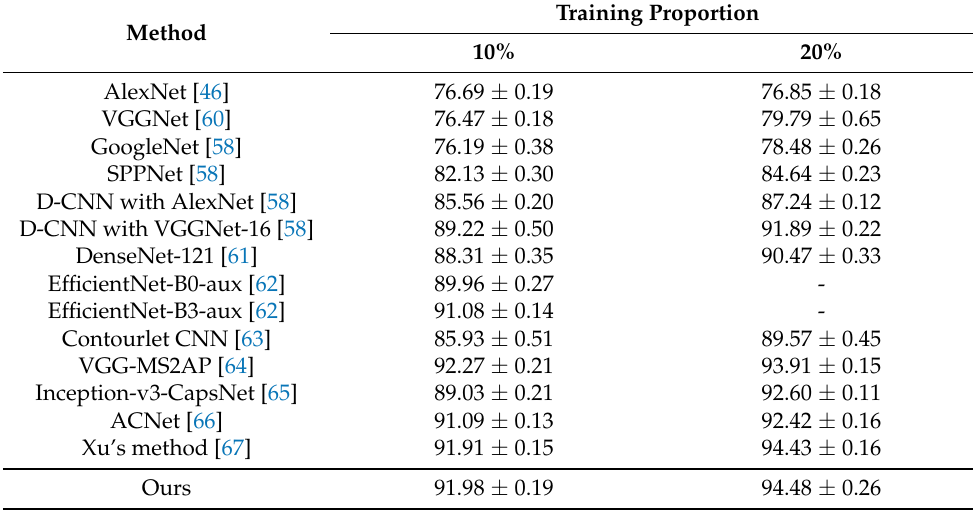
Table 4. Classification accuracy on the NWPU dataset compared to CNN-based models (OA ± STD).